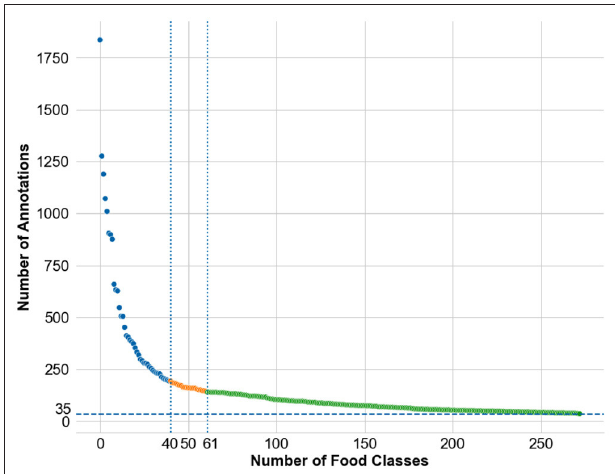
FIGURE 3 | Distribution of number of annotations available across the food classes in the dataset. The individual food class names are not mentioned for readability. The public release of the dataset was done in three phases—the first phase of the public release consisted of the images from the top-40 classes, the second phase of the public release consisted of the images from the top-61 classes, and the third phase of the public release consisted of the images from the top-273 classes.